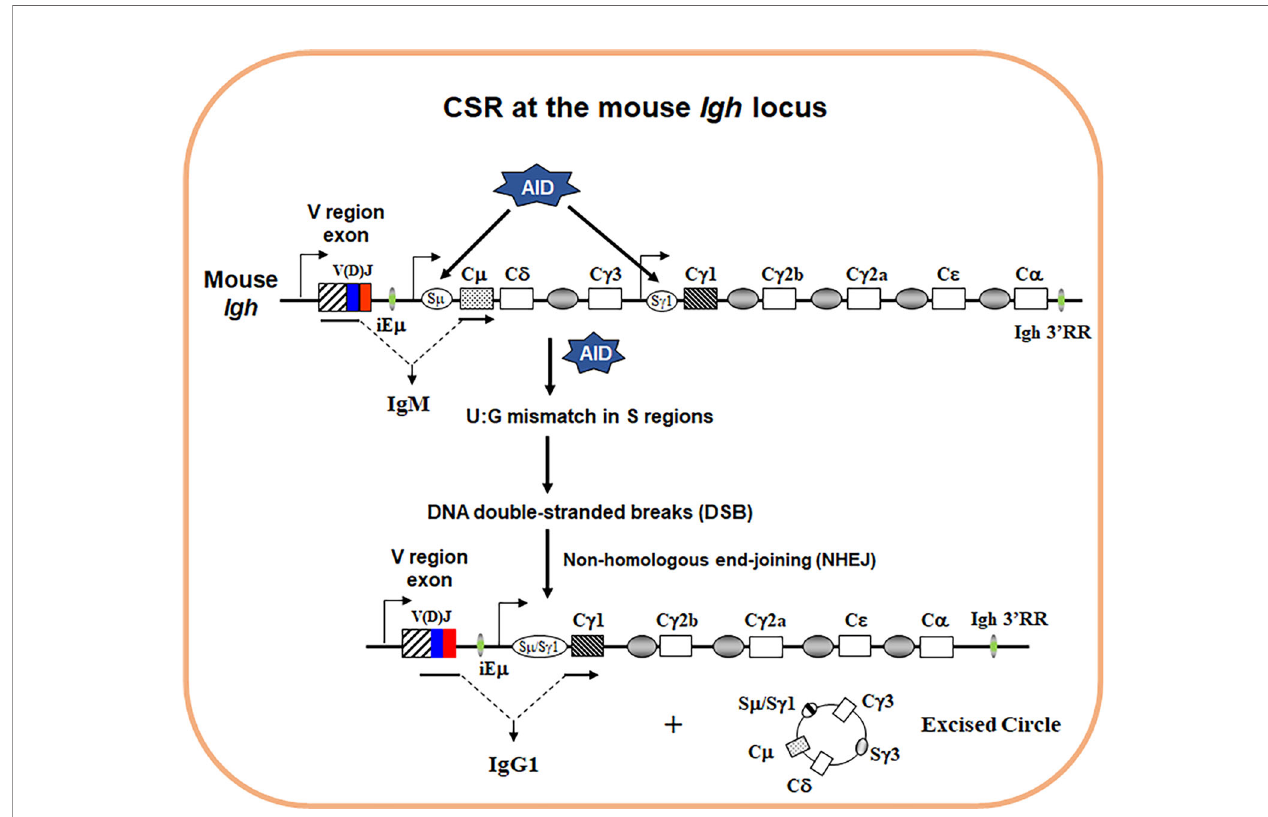
FIGURE 1 | Schematics of IgH CSR. The genomic con fi guration of the rearranged Igh locus in mouse. Variable (V) region exon is located upstream, and eight different sets of C H exons are located downstream. AID introduces point mutations into V region exon during somatic hypermutation (SHM) (not depicted). To initiate CSR, AID introduces U:G mismatches in the donor Sµ and the downstream acceptor S g 1 regions that are subsequently converted into DNA double-stranded breaks (DSBs) by basic excision and mismatch repair pathways. Broken S regions are joined by non-homologous end-joining (NHEJ), whereas the intervening DNA is excised as a circle. Active transcription is essential for both SHM/CSR with promoters depicted for V region, Sµ and S g 1 region (arrows). When CSR is completed, originally expressed Cµ exons are replaced by C g 1 exons that are juxtaposed to the same V region exon. Therefore, naïve IgM + B cells switch to activated IgG1 + B